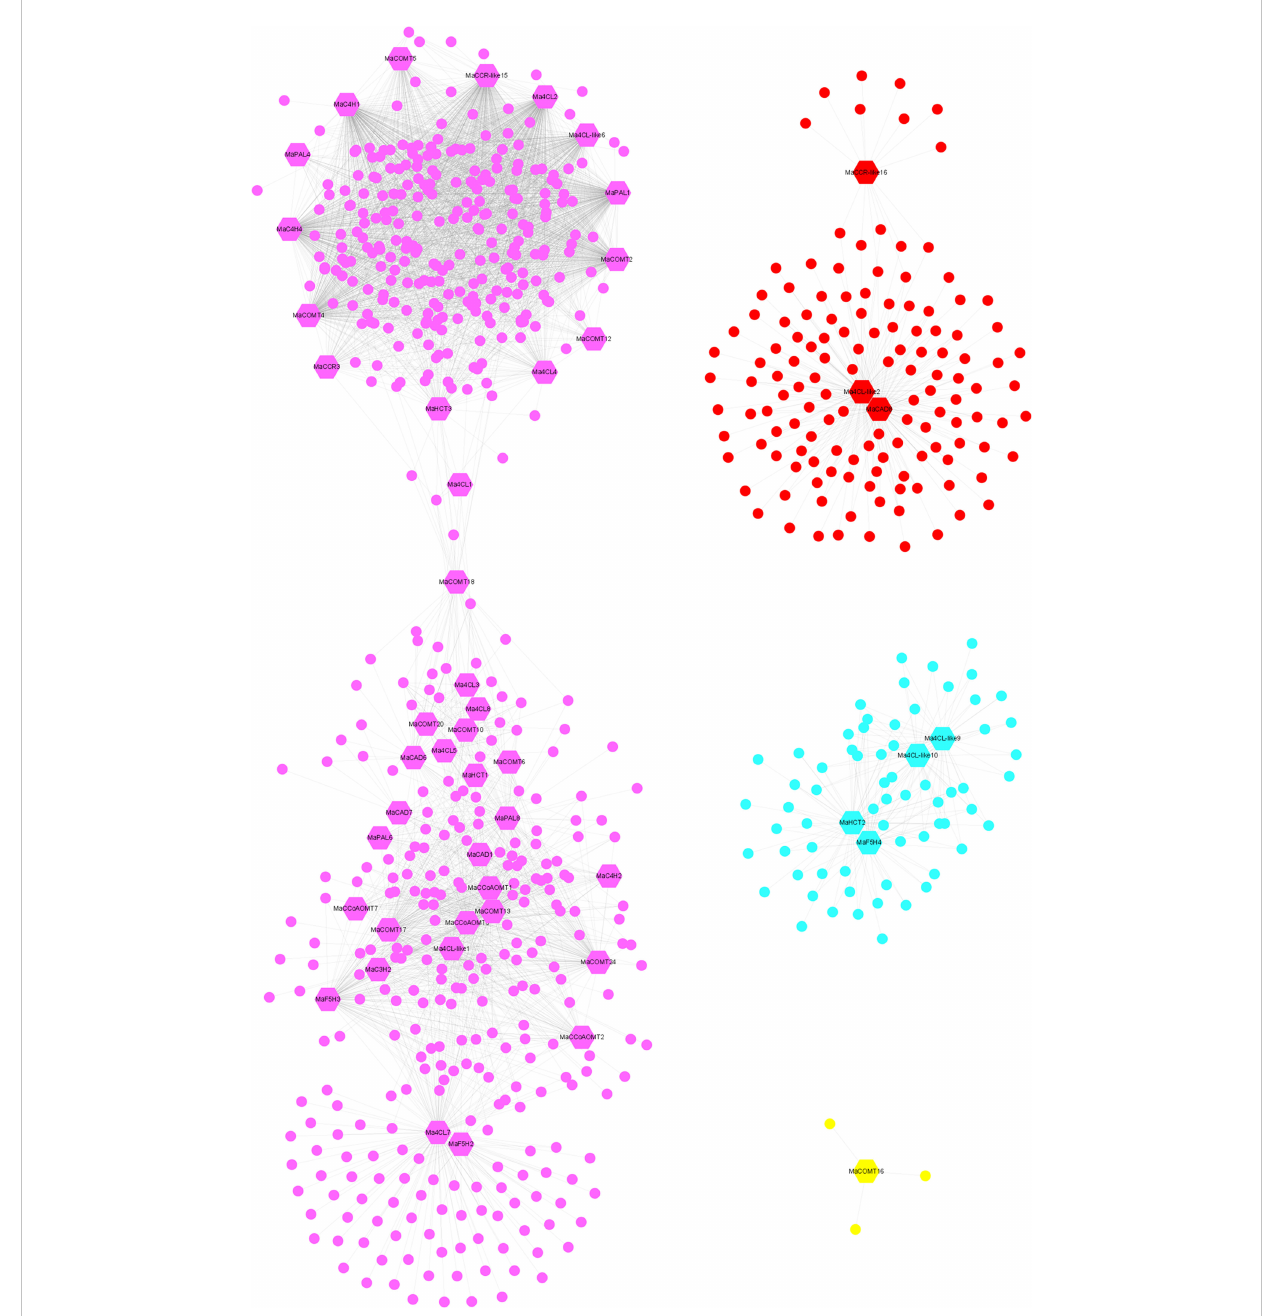
FIGURE 8 Co-expression network of banana generated using the lignin biosynthesis genes as guides. The network comprised 725 TF genes (nodes); the hexagon represented lignin biosynthesis